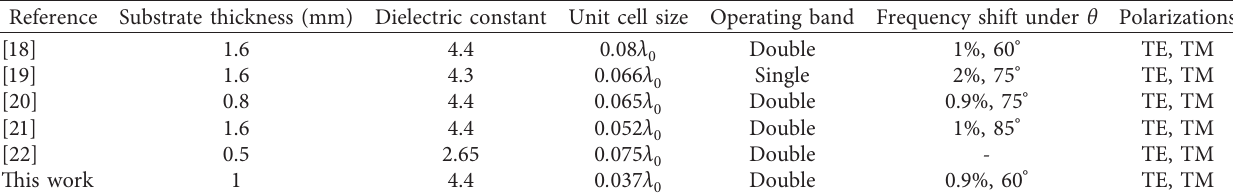
Table 1: Performance